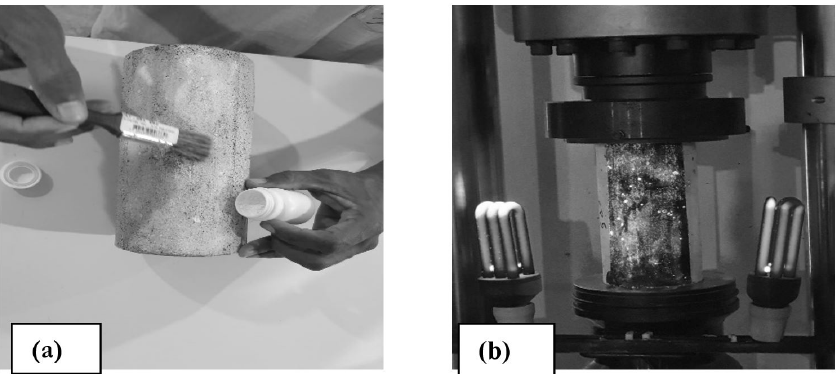
Figure 1: a) application of the contrast with flourishing powder b) Enhancement of the contrast with UV light [11]